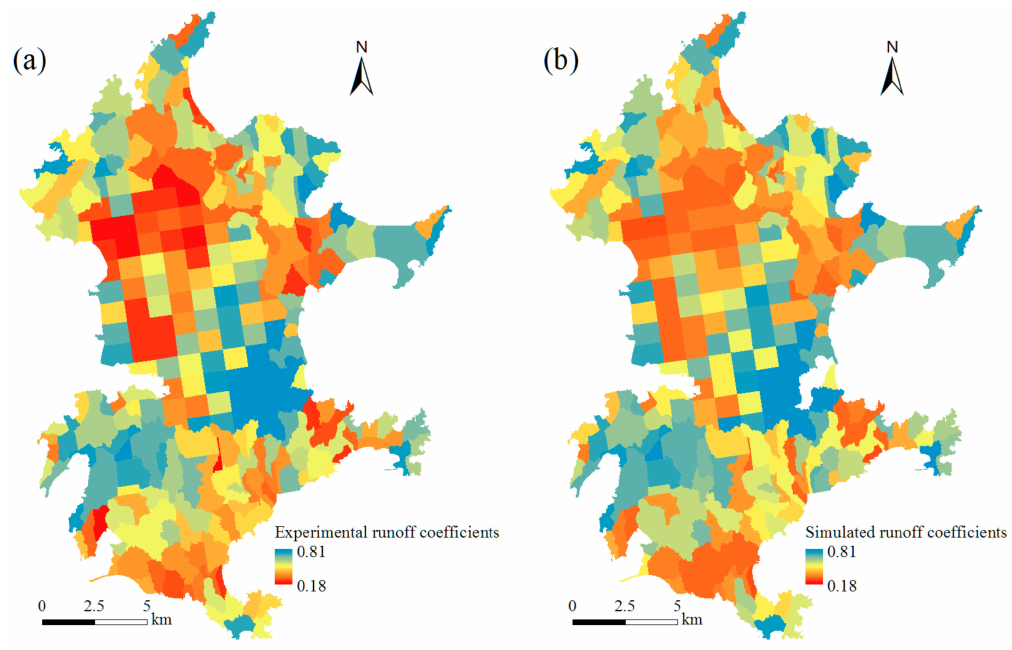
Figure 4. Spatial distribution of runoff coefficients derived from ( a ) field experiments and ( b ) HIMS (Hydro-Informatic Modeling System) model